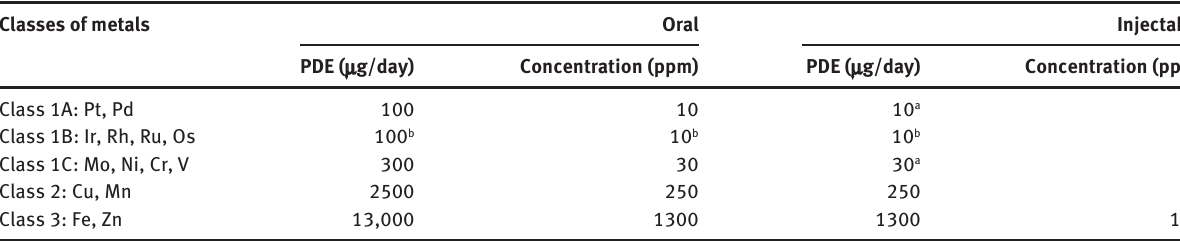
Table 3 Limits of inorganic impurities in oral and injectable (CPMP/SWP/QWP/4446/00). Classes of